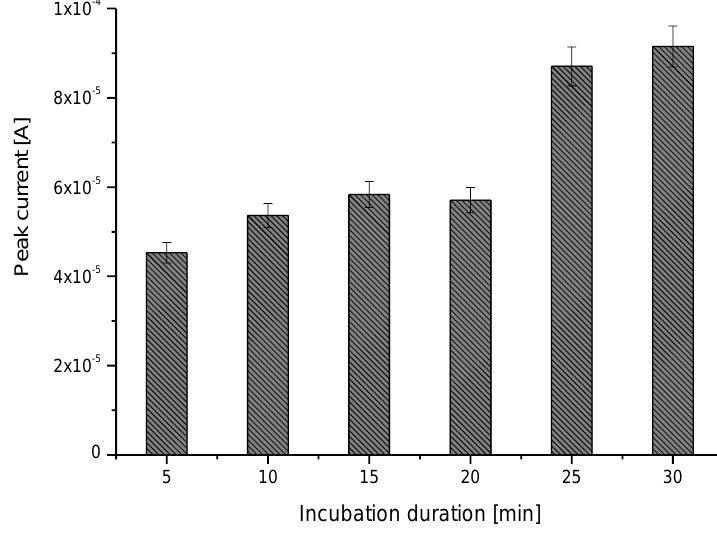
Figure 1. Monitoring of glyphosate oxidation peak current variation versus incubation duration in a pyrrole/glyphosate/LiClO 4 solution.